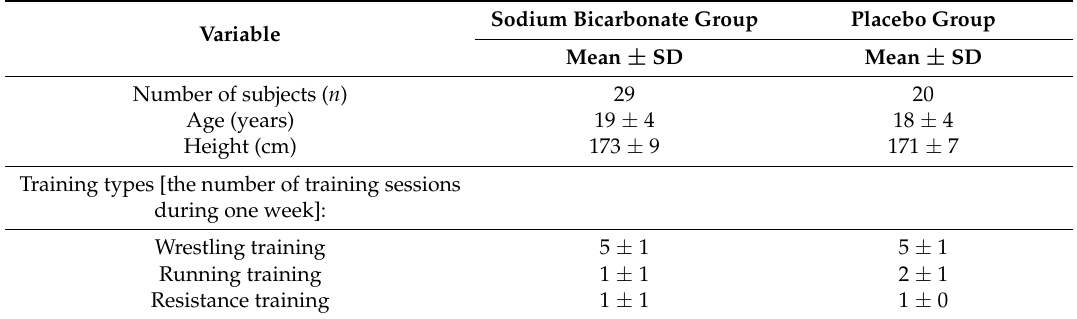
Table 1. Participants’